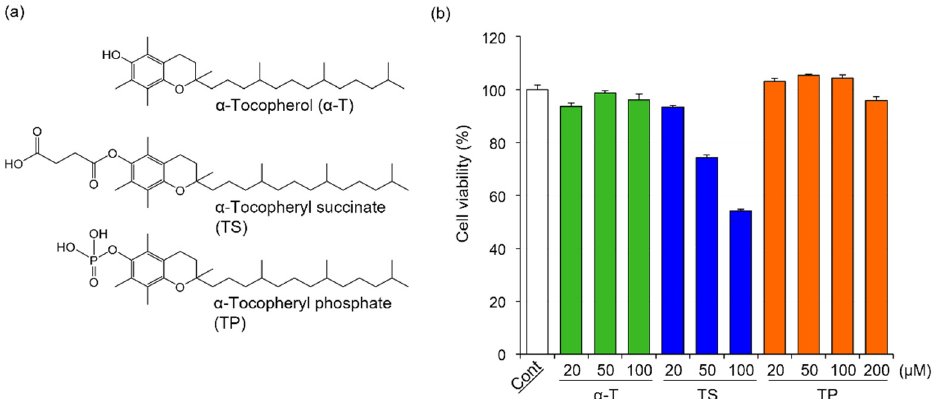
Figure 1. Chemical structures of α -T, TS, and TP, and their effects on the viability of HFLS-RA. ( a ) Chemical structures of α -T, TS, and TP, ( b ) Effects of α -T, TS, and TP on the viability of HFLS-RA. HFLS-RA cells were treated with 50 µ M α -T, 20 µ M TS and 50 µ M TP for 24 h. The cell viability was determined by WST-1 assay. Values represent the means of three individual experiments. Bars represent SD.